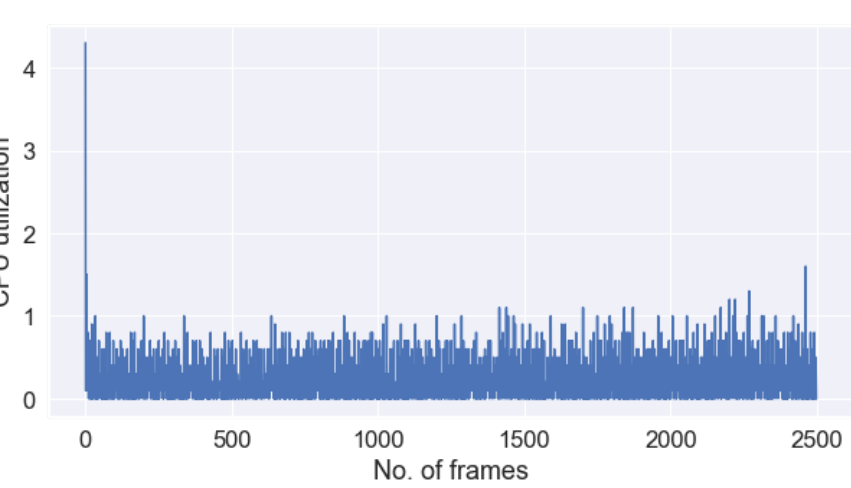
Figure 7. CPU utilization in standalone machine before OpenStack